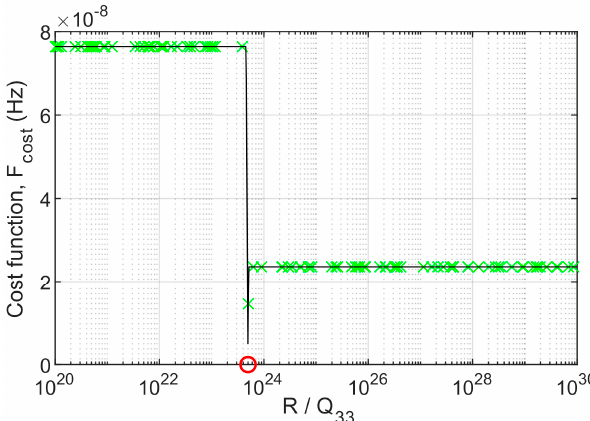
Figure 9. Convergence graph of genetic algorithm fitness value. The selection range of parameter R / Q 33 in Figure 10 is